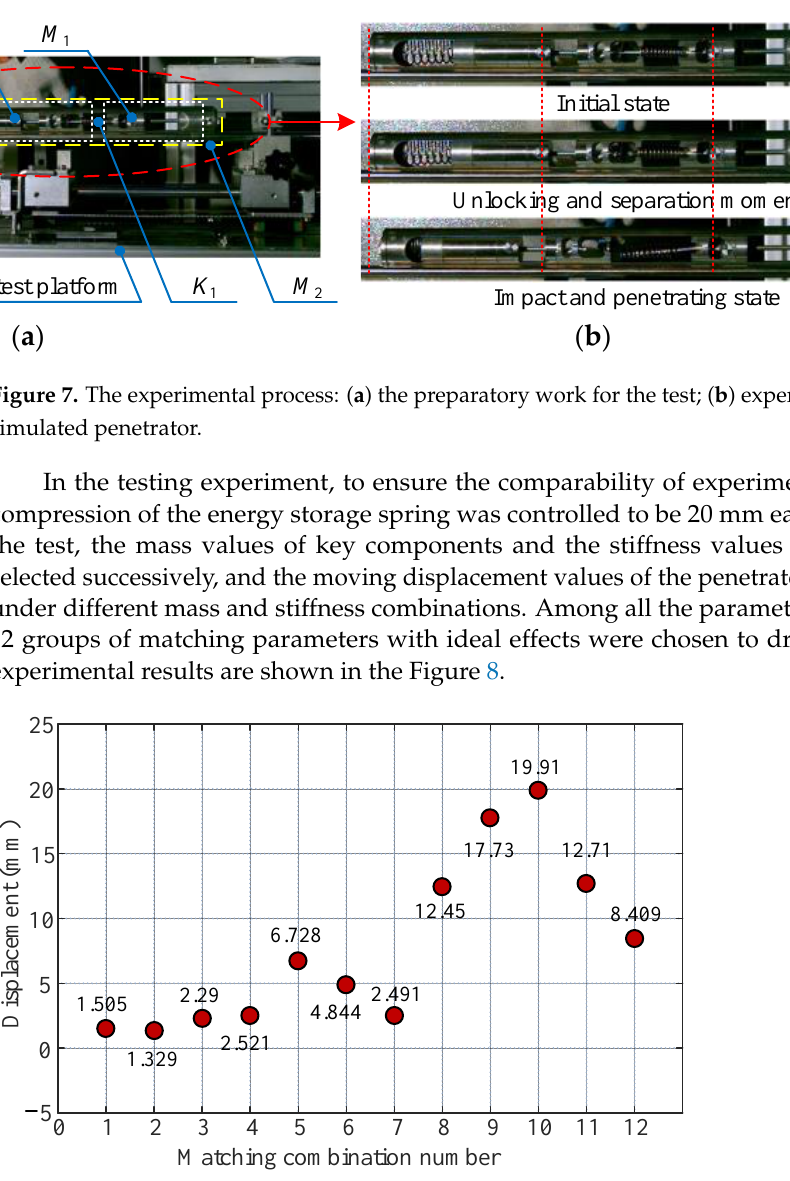
Figure 8. The displacement data points under 12 groups of matching parameters.